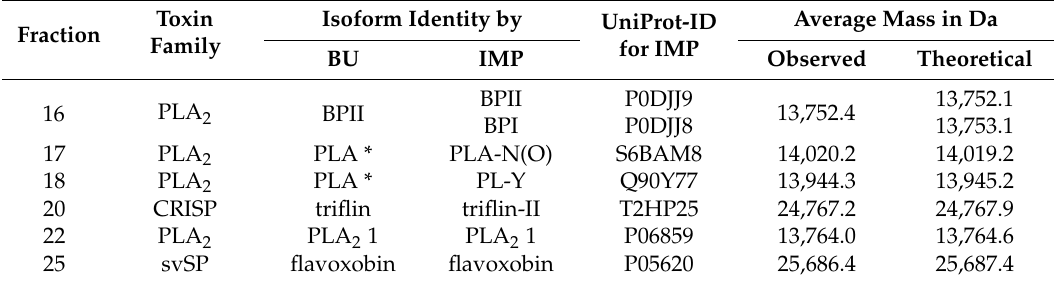
Table 2. Identification of several venom isoforms by mass comparison. The bottom-up method (BU) in combination with the intact mass profiling (IMP) leads to a database-oriented identification of the isoforms in the crude venom. The theoretical mass includes oxidized cysteines for predicted Cys-Cys